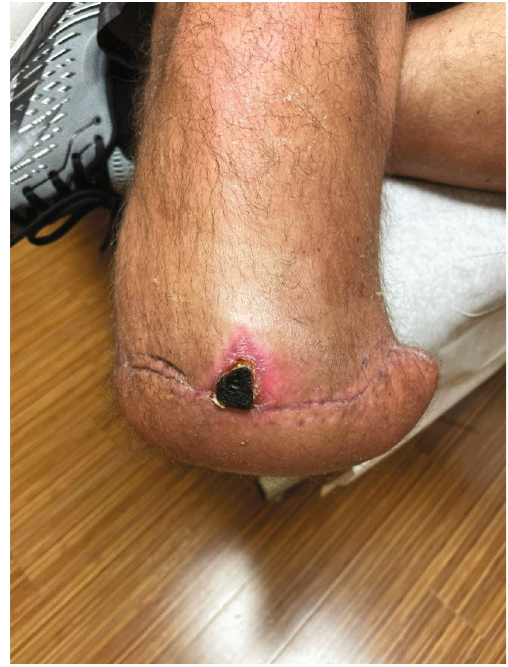
Figure 5: Photograph of the right lower extremity stump 77 days following the initial right transtibial